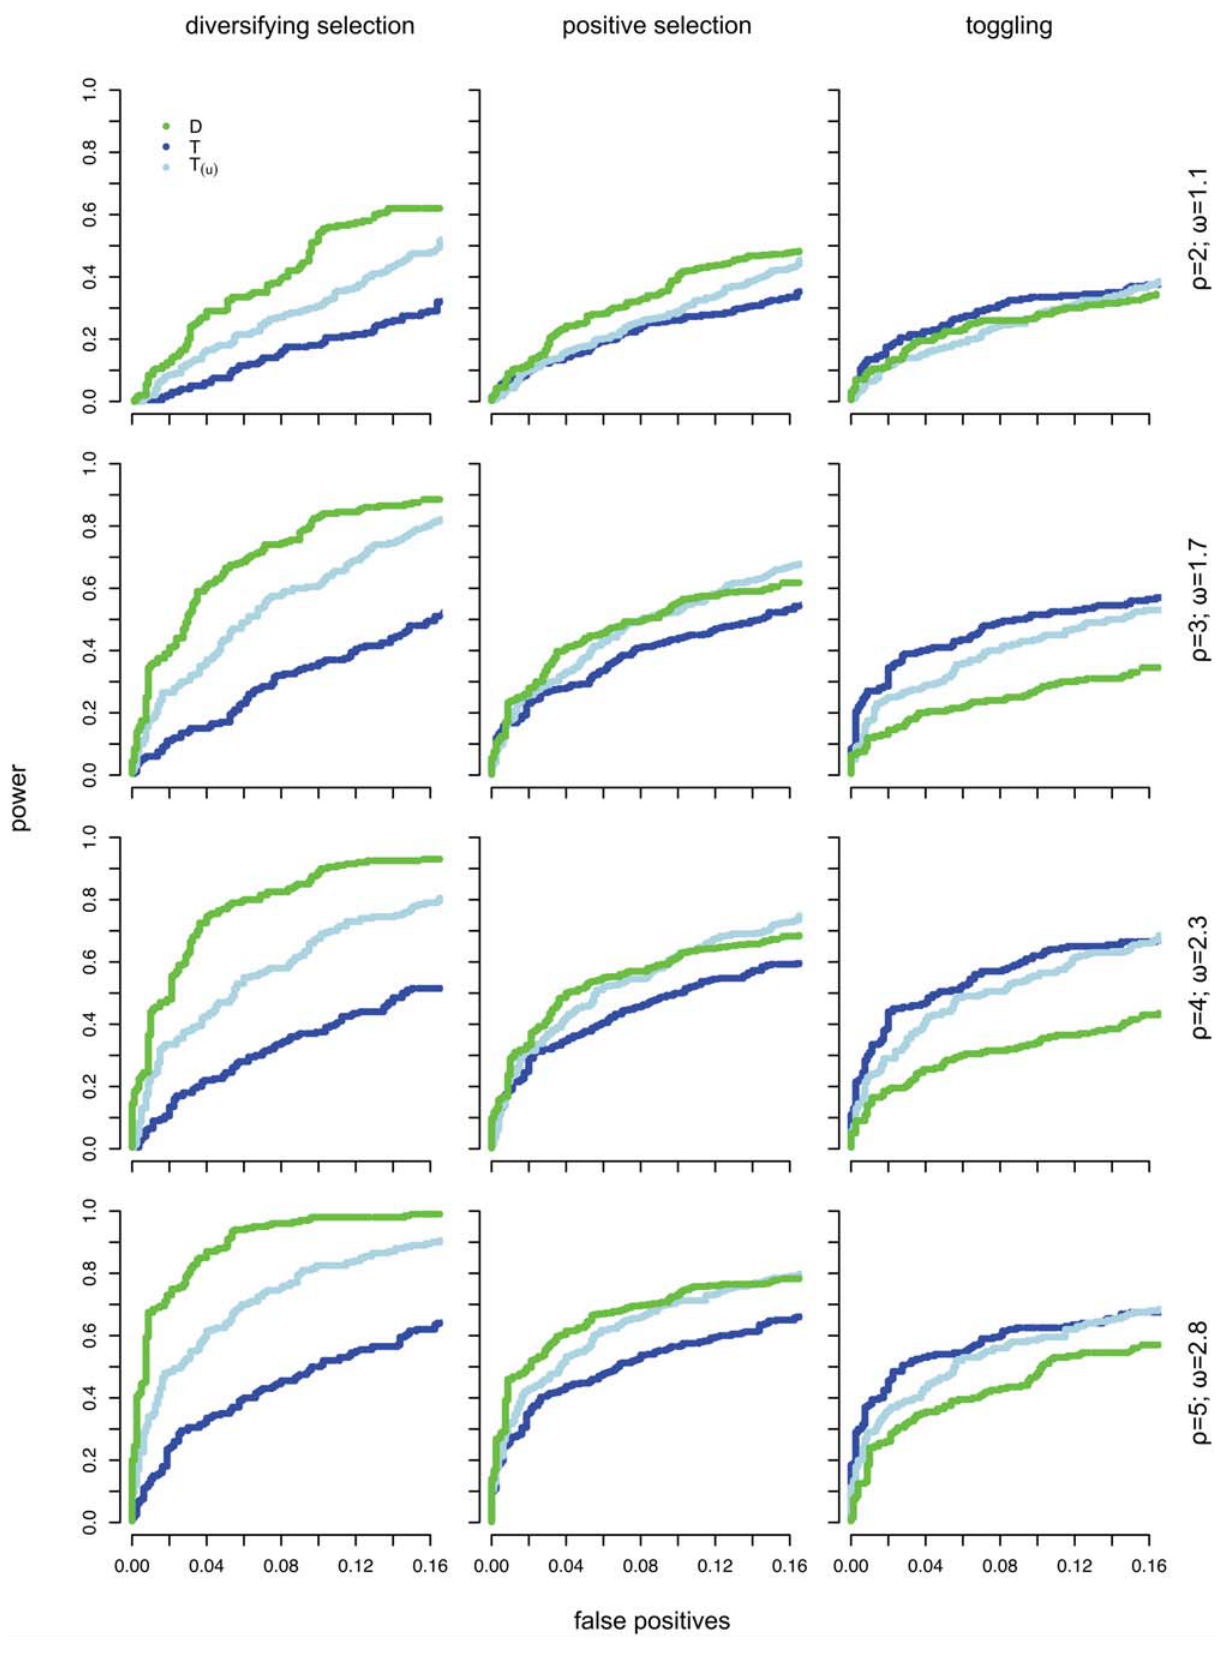
Figure 3. Evaluationof power and false positives. ROC curves indicating power and false positive rates for the detection of diversifying selection (left panel), diversifying selection and toggling (centre panel), and toggling (right panel) for each of the five parameter sets (Table 1) simulated. doi:10.1371/journal.ppat.1000242.g003 PLoS Pathogens |